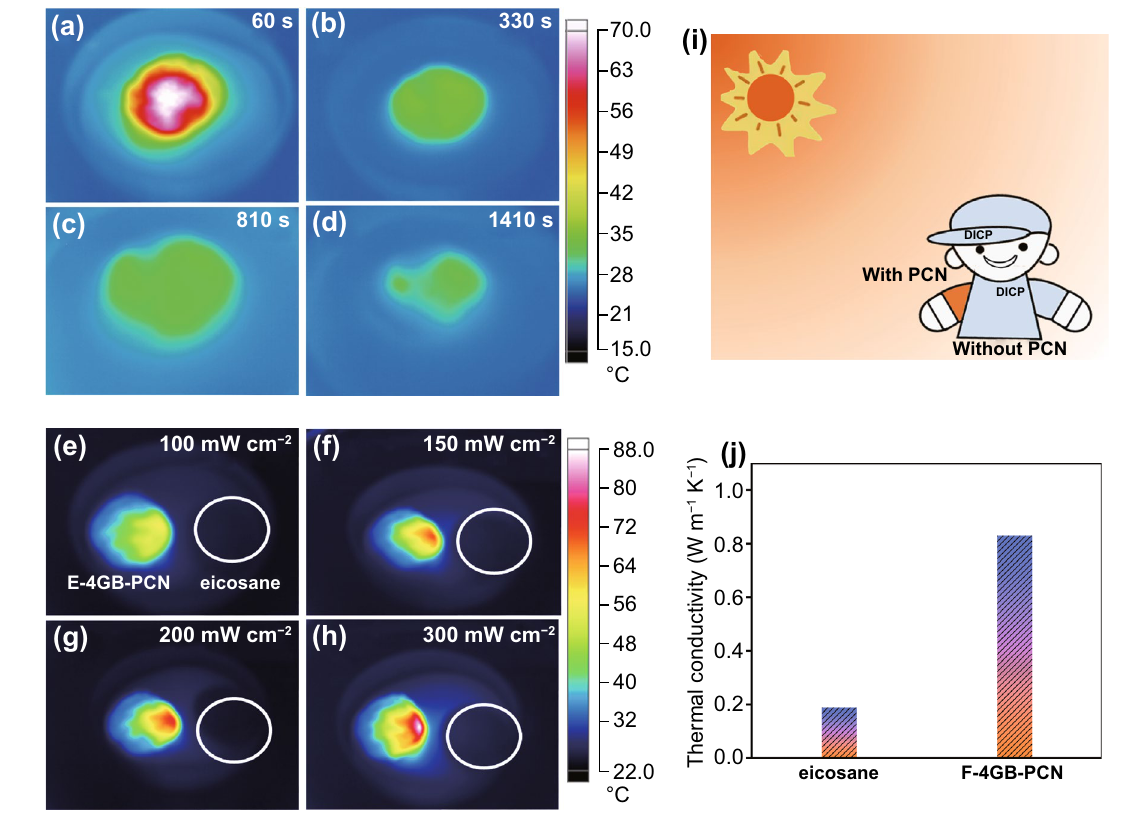
Fig. 3 Solar–thermal conversion of GB-PCN. a – d Infrared imaging pictures of the solar–thermal conversion process of E-4 GB-PCN under photo-illumination of 200 mW cm −2 for different times. e – h Infrared imaging pictures of the solar–thermal conversion process of E-4 GB-PCN and eicosane under different illumination intensity for 90 s. i Schematic diagram of solar–thermal conversion in the cloth (GB-PCN in the cloth- ing on the left arm, and no GB-PCN in the clothing on the right arm). j Thermal conductivity of eicosane and E-4